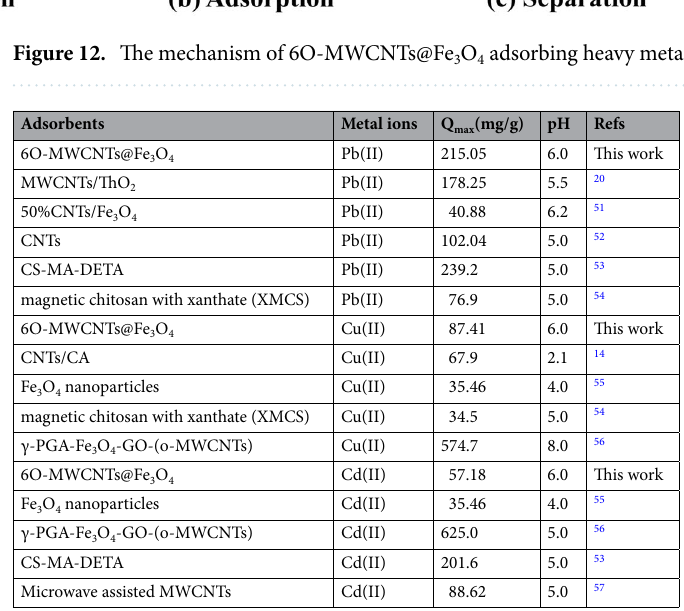
Table 2. Comparison of the maximum adsorption capacity of Cd(II), Cu(II) and Pb(II) ions on various adsorbents.